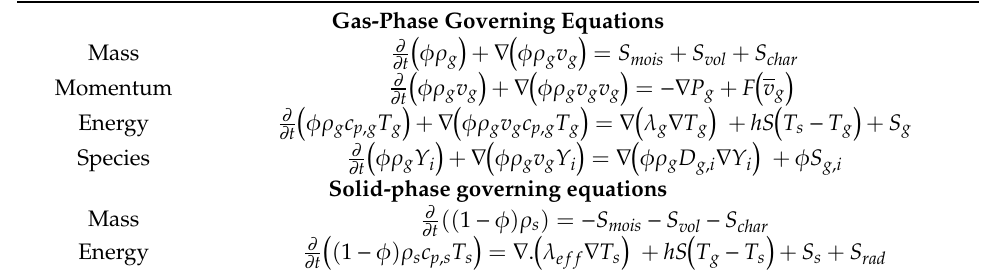
Table 1. Conservation equations regarding the solid and gas phase of fuel packed bed conversion.